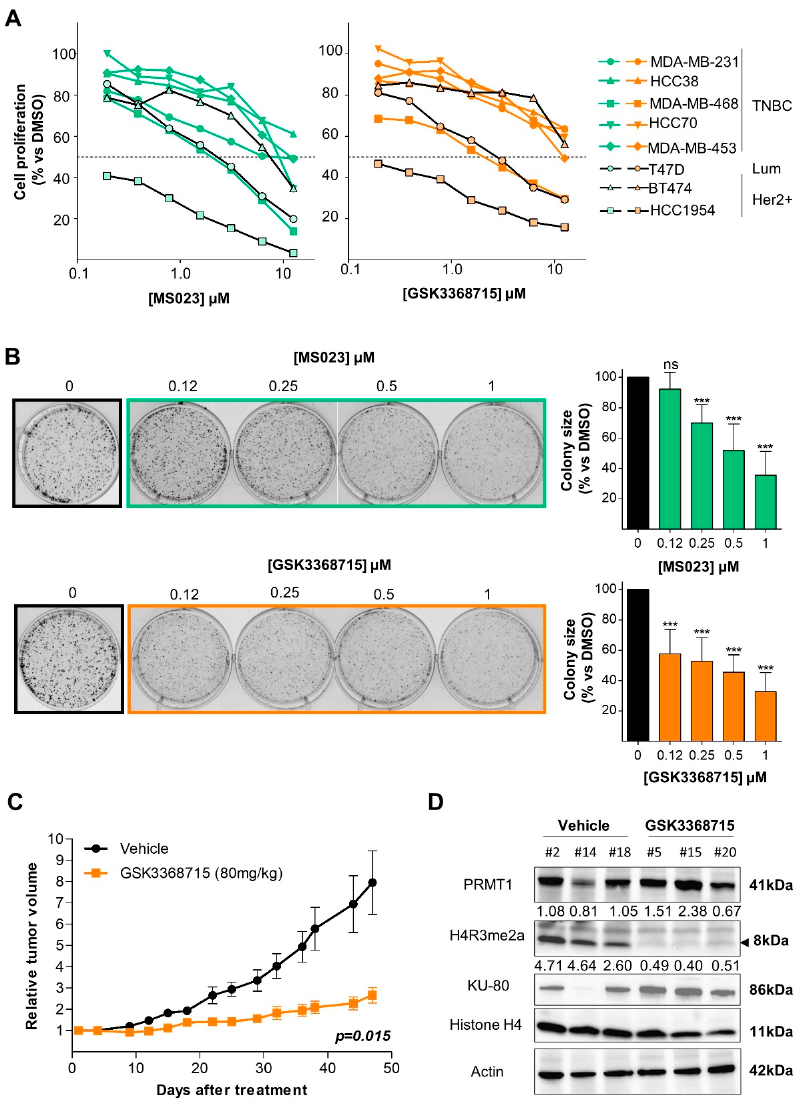
Figure 3. Type I PRMT inhibitors reduce cell viability and tumor growth. ( A ) Type I PRMT inhibitors decrease BC cell viability. TNBC, luminal (Lum), and Her2+ cells were treated with MS023 ( left panel ) or GSK3368715 ( right panel ) for 7 days, except MDA-MB-231 (4 days), and proliferation was determined by MTT or WST1 assays. Results are presented as the average percentage of cell growth relative to DMSO-treated cells from three independent experiments. ( B ) Type I PRMT inhibitors reduce the growth of colonies when MDA-MB-468 cells were cultured on plastic for 9 days after MS023 ( top ) or GSK3368715 ( bottom ) treatment. Quantification of colony size is expressed as a percentage relative to DMSO-treated cells, represented as the mean ± SD from at least three independent experiments ( right panel ). Pictures are from a single experiment representative of three independent experiments ( left panel ). p -values are from a Student t -test and represented as *** p < 0.001; ns = not significant. C, GSK3368715 slows tumor growth. Tumors derived from MDA- MB-468 cells were subcutaneously grafted into 12 mice (6 vehicle-treated, black; 6 GSK3368715-treated, orange). Growth curves were obtained by plotting mean relative tumor volume ± SEM as a function of time. p -value was calculated using a Mann–Whitney U test. ( D ) GSK3368715 inhibits PRMT1 activity in vivo . PRMT1 expression (anti-PRMT1) and activity (anti-H4R3me2a) were analyzed in the tumors excised from 3 vehicle (#2, #14, #18) or GSK3368715 (#5, #15, #20)-treated mice at the end of the experiment ( C ). Antibodies against histone H4, actin and KU-80 were used as controls and quantification of the bands (normalized to the actin band) are indicated below each